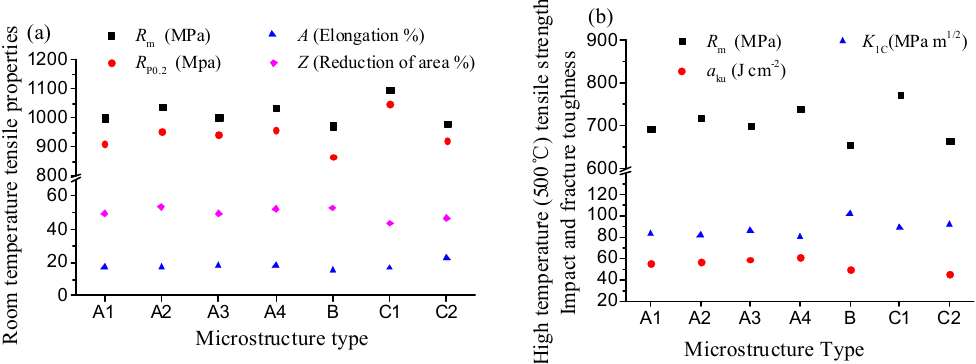
Figure 6. Mechanical properties of TA15 alloy with different microstructures: ( a ) Room-temperature tensile properties; ( b ) high-temperature (500 °C) tensile strength, impact, and fracture toughness. For TA15 alloy the bimodal microstructures were obtained through near- β forging and AC (Figure 1d, type A1 in Table 2), near- β forging + LTA (Figure 2, types A3 and A4 in Table 2), and near- β forging + NTS (near- β toughening and strengthening) (Figure 4c, type A2 in Table 2), respectively. The volume fraction of primary equiaxed α p changed between 18.2% and 21.6%, and average grain size (diameter) between 6.26 and 7.20 μ m (Figure 5). The volume fraction of the Widmanstätten α W changed between 47.7% and 58.2%, but its distribution and thickness showed an obvious difference. For microstructure of type A1, there existed a great deal of very thin interlaced α W with a thickness of about 0.35 μ m appearing, and spreading all over the matrix (Figure 1d, near- β forging/AC). For type A4 (Figure 2b, near- β forging/WQ + LTA) thin interlaced α W were obtained (0.45 μ m). For type A3 (Figure 2a, near- β forging/AC + LTA) the α W was relatively thick, 0.75 μ m, and showed a clustered distribution. For type A2 (Figure 4c, near- β forging/AC + NTS) long and thin clustered α W appeared.